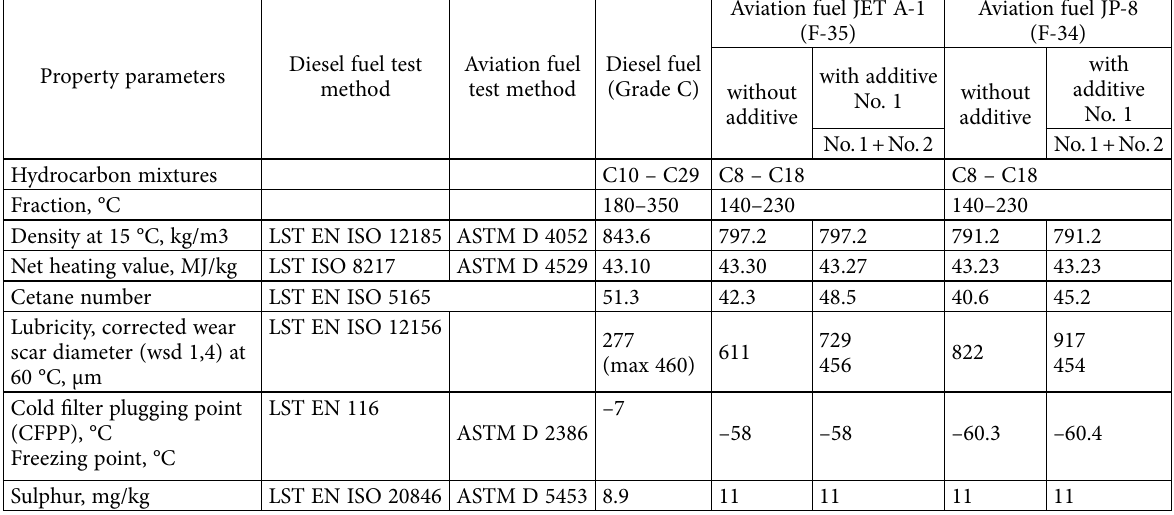
Table 1. Fuel property